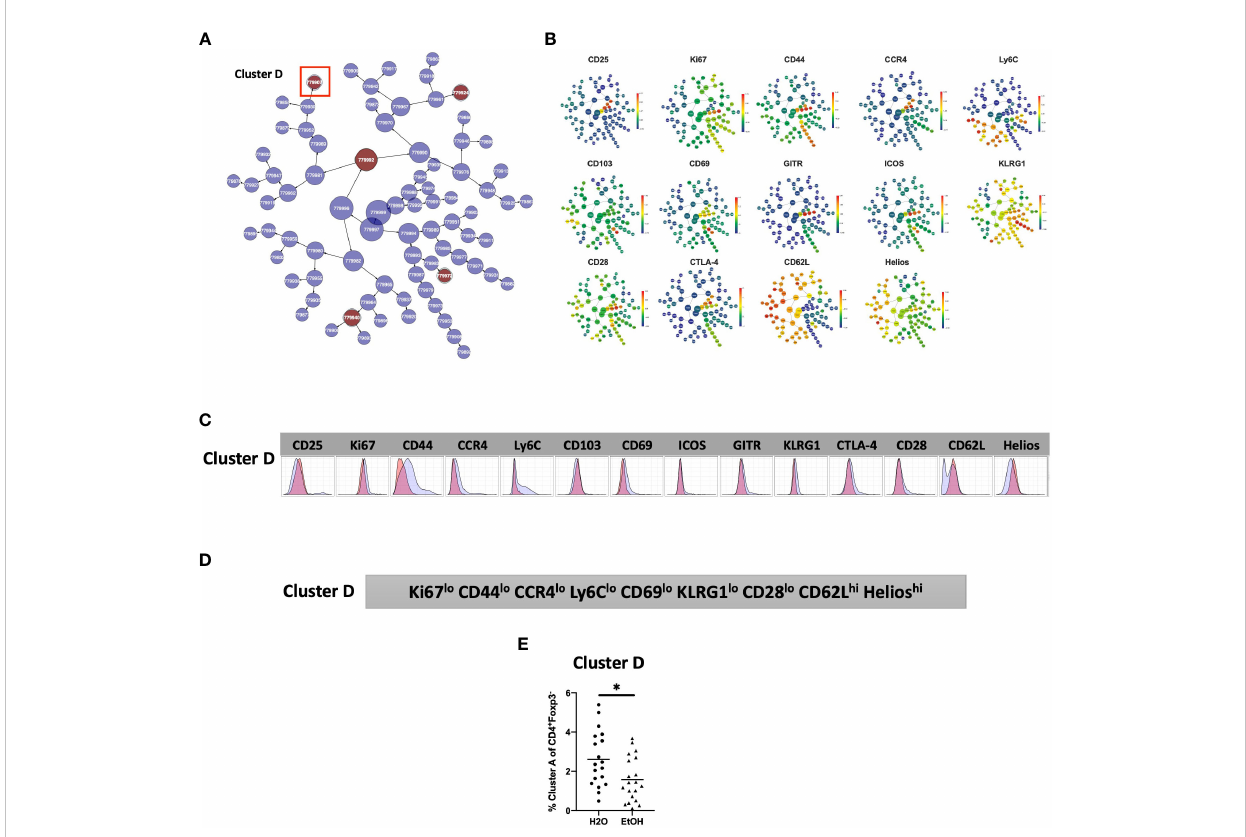
FIGURE 5 Phenotypic analysis of one CD4 + T Conv cluster that is signi fi cantly different in alcohol-exposed mice. Following CITRUS modeling and identi fi cation of three CD4 + T Conv clusters predictive of alcohol drinking mice, phenotypic cluster characterization was performed by assessing (A) marker expression on the viSNE map with the overlaid clusters, (B) CITRUS clusters of interest shown in the feature plots in (A) were compared to expression on corresponding the heatmap marker plots in (B, C) CITRUS marker histogram expression was visualized where blue represents background expression and red represents expression within the cluster of interest. The fi nal phenotypic characterization pro fi le assigned to the cluster of interest is shown in (D) . (E) Manual gating demonstrated that the frequency of cells within Cluster (D) (1.6 ± 0.3% vs . 2.6 ± 0.3%, p=0.01) was statistically signi fi cantly decreased in alcohol exposed mice relative to water exposed. Data were tested for normality and compared using t test.